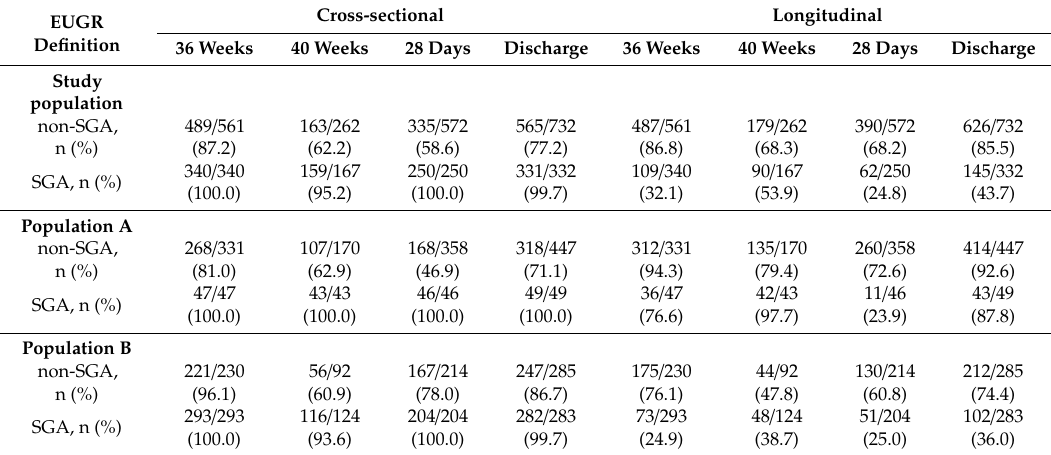
Table 3. Infants with EUGR defined in cross-sectional and longitudinal way at the four di ff erent t-times.